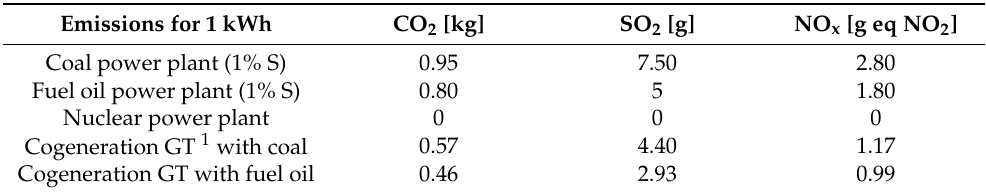
Table 1. Comparison of the gaseous pollutant emissions, according to the processes of electrical energy production.